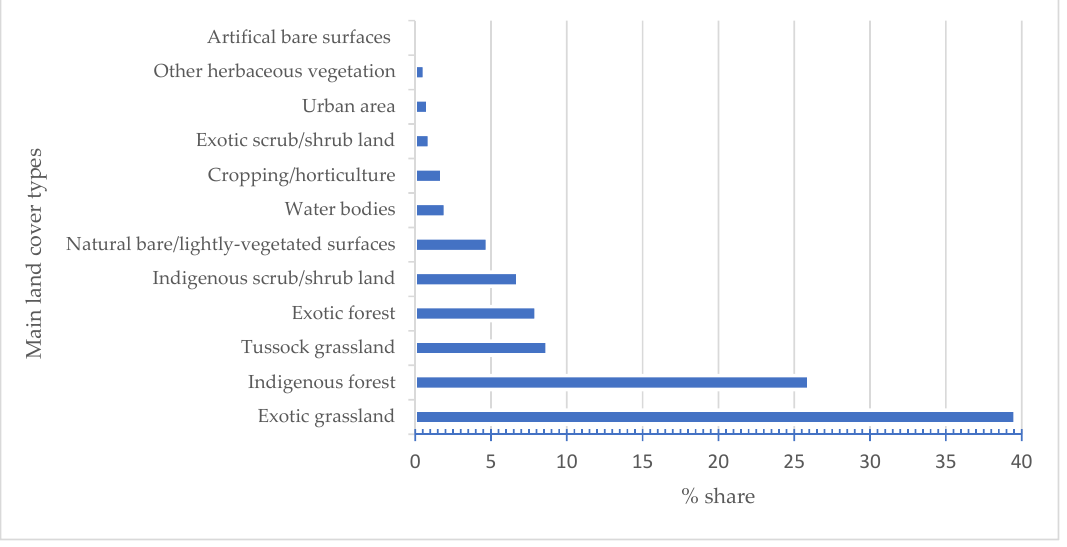
Figure 2. The percentage share of NZ total land area by main land cover types in 2012. (This work is based on/includes Stats NZ’s data which are licensed by Stats NZ for reuse under the Creative Commons Attribution 4.0 International licence [21]).